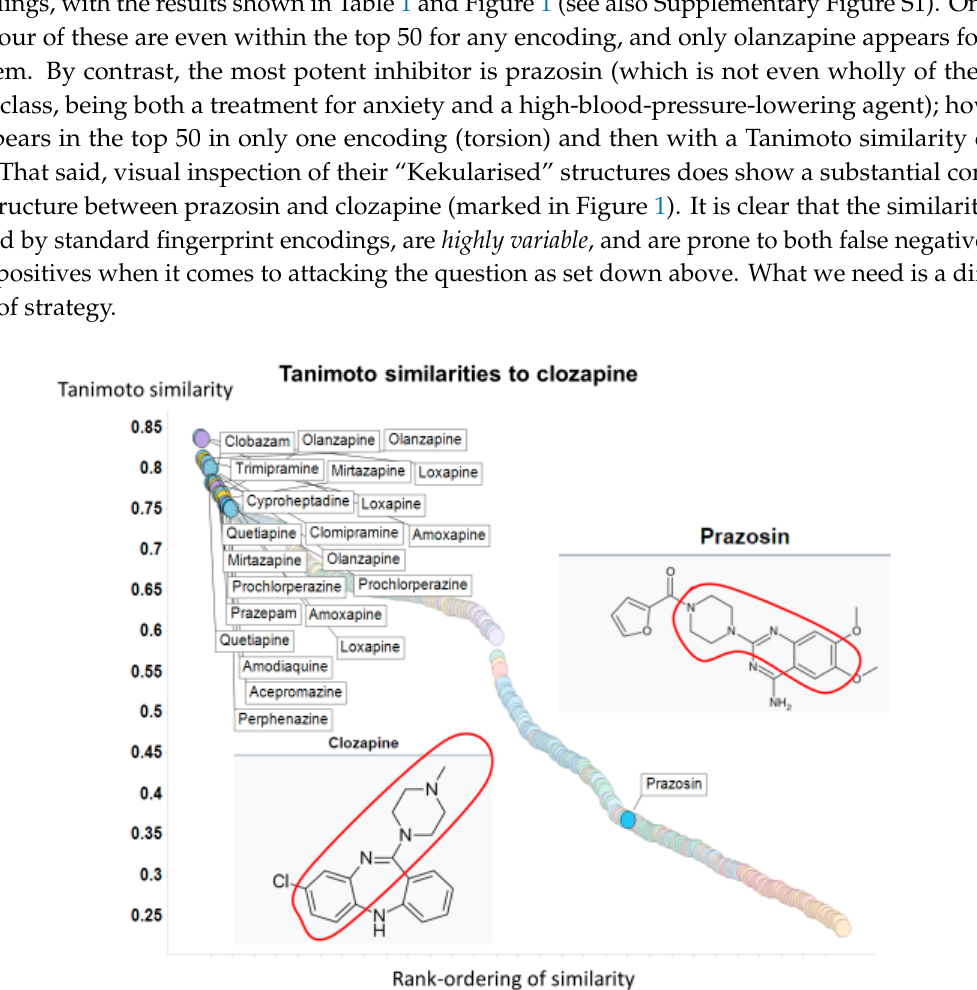
Figure 1. Tanimoto similarities of various molecules to clozapine using the Torsion encoding from Figure1. RDKit.